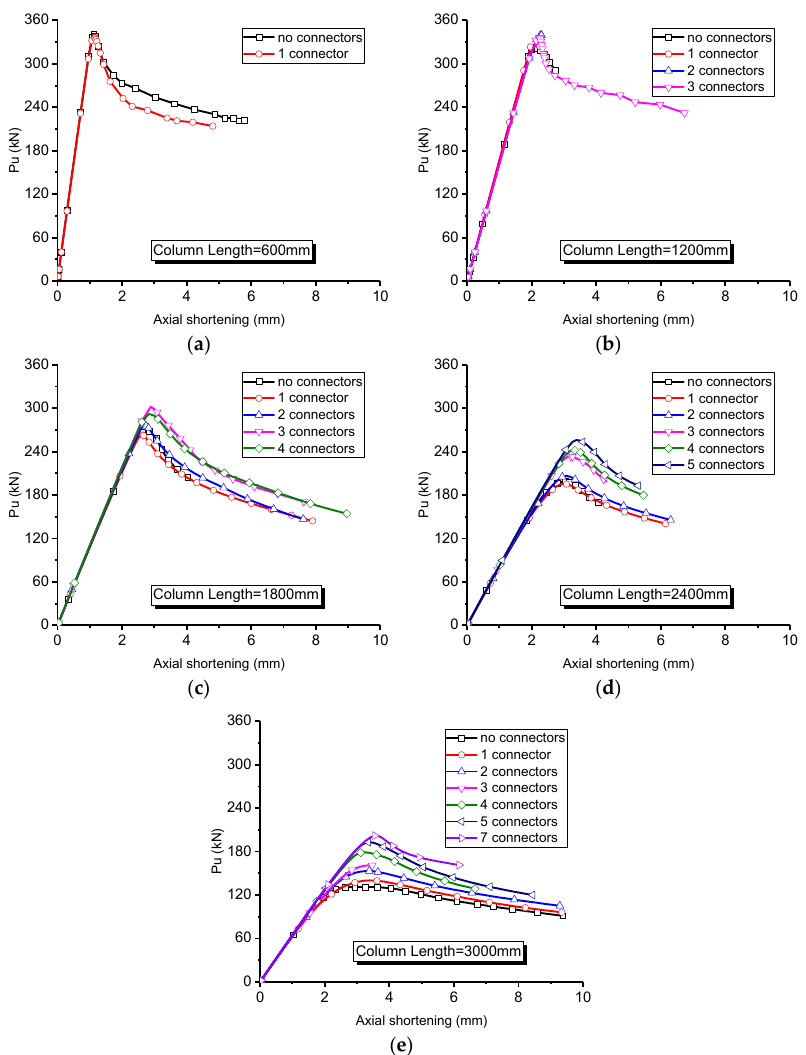
Figure 14. Effect of number of connectors: ( a ) column length is 600mm; ( b ) column length is 1200mm; ( c ) column length is 1800mm; ( d ) column length is 2400mm; ( e ) column length is 3000mm.